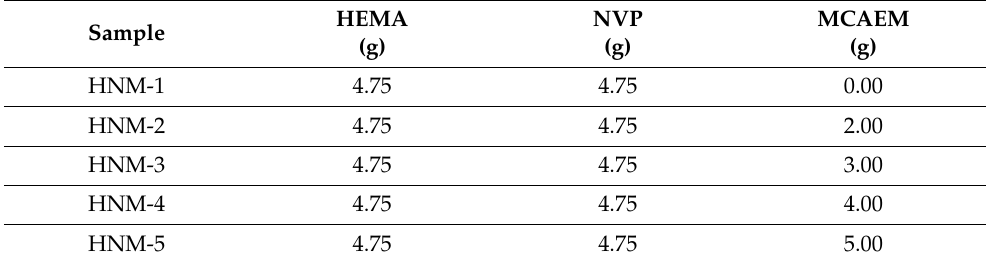
Table 4. The comonomer feed composition for synthesizing copolymer